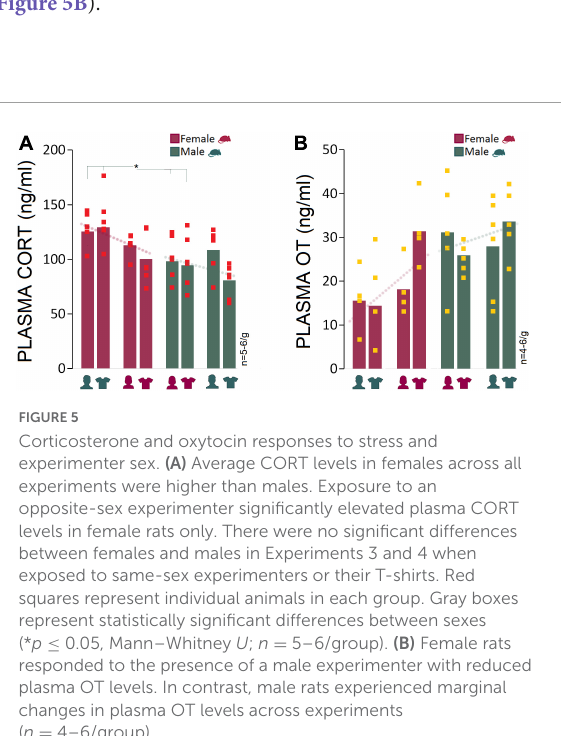
10.78%, Figure 4C ]. Thus, although behavioral responses to